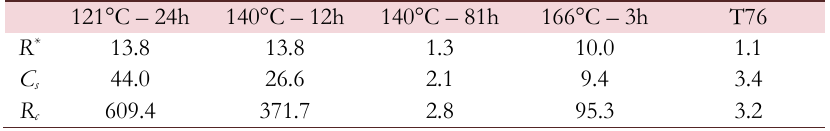
Table 4: Comparison of the corrosion resistance for the ageing conditions